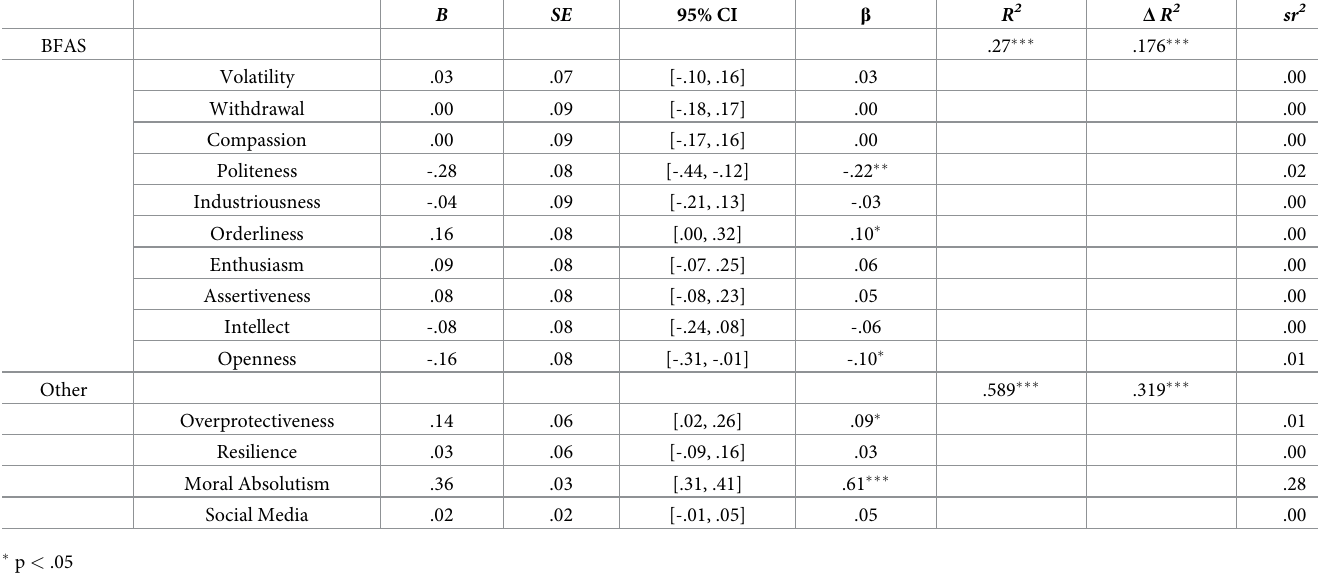
Table 6. Step 3 of the hierarchical multiple regression of BFAS, parenting, and personal factors of WI